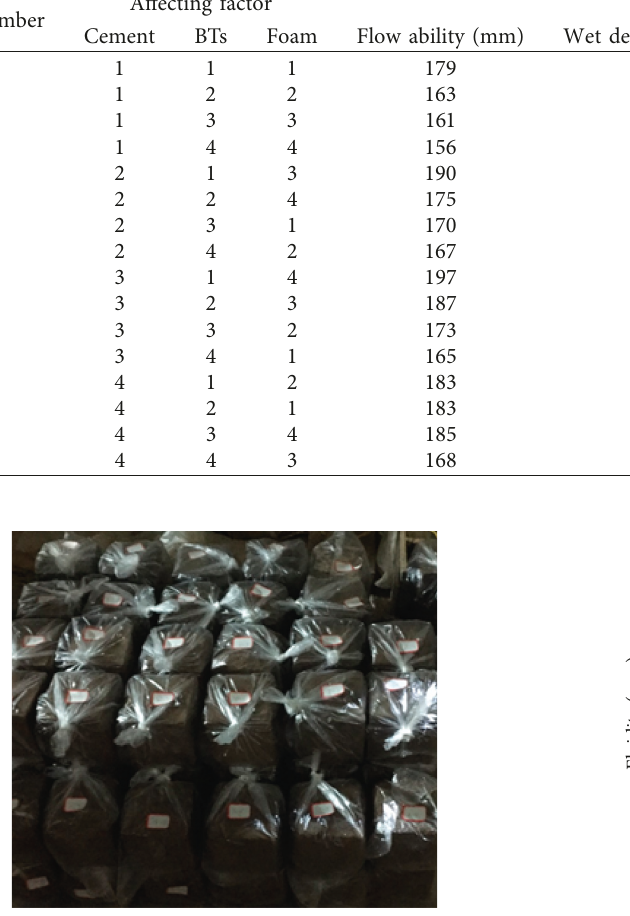
Figure 2: Sealed curing of the FMLSB samples.